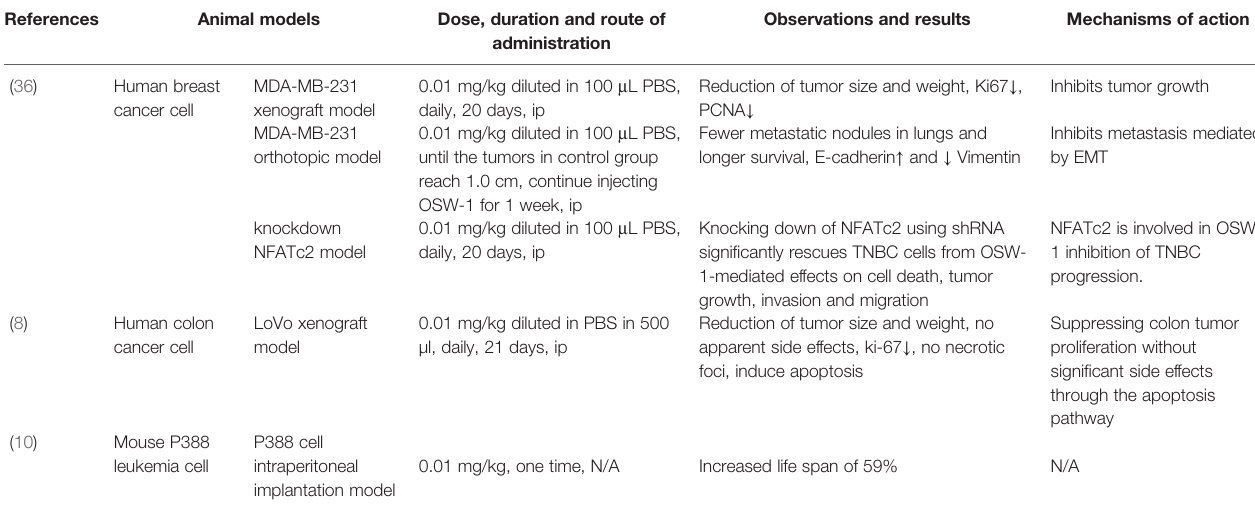
TABLE 2 | The anti-cancer effects of OSW-1 in vivo tumor bearing animal